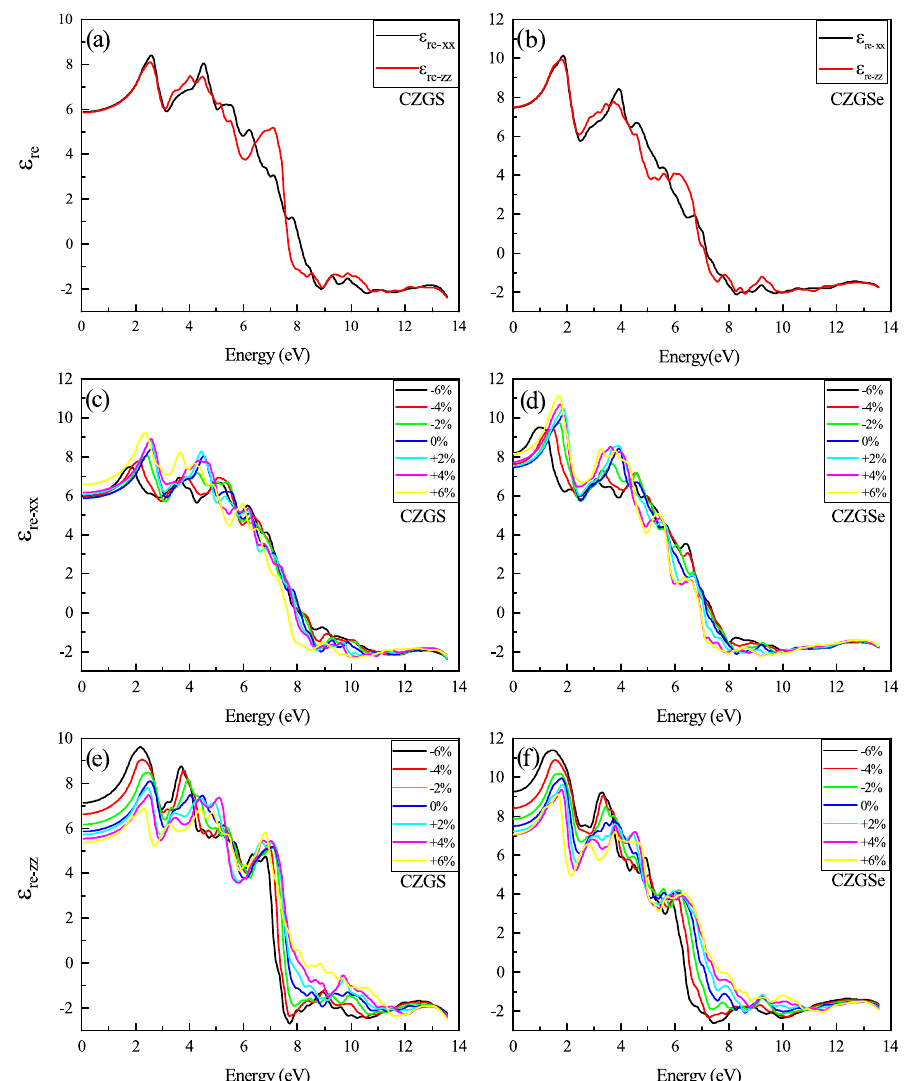
Figure 8. The variation of the real part of the dielectric function spectra as a function of the incident photon energy for both materials CZGS and CZGSe: ( a , b ) are the unstrained cases, ( c – f ) are the strained cases. ε re − xx and ε re − zz are the real parts of the dielectric function for light polarization along XX and ZZ